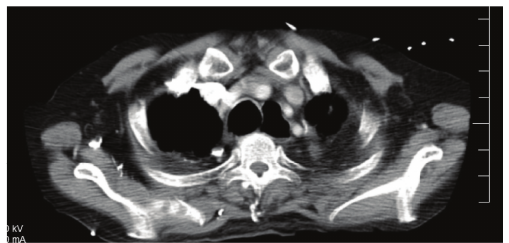
Figure 2: Chest computography shows the dilated esophagus above the fibrosing mediastinum.